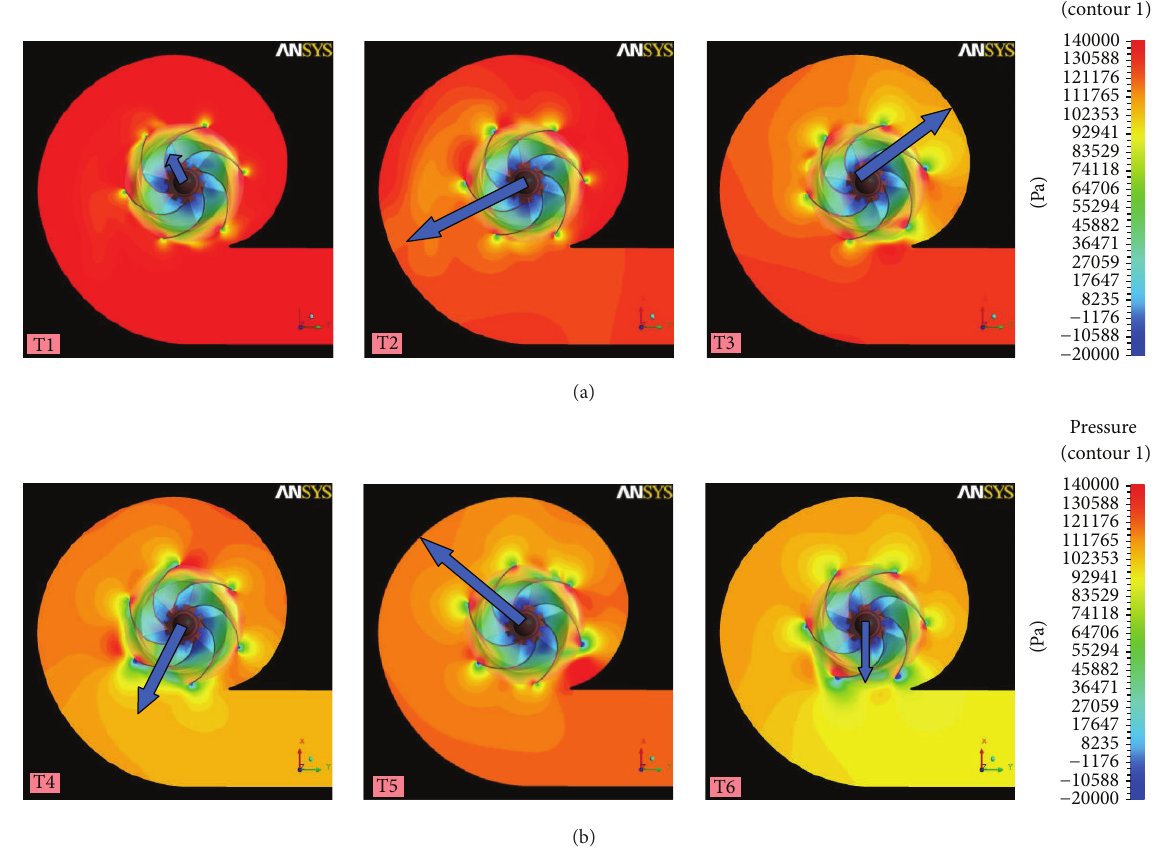
Figure 14: Instantaneous pressure field and radial trust evolution for the following operating point: − rpm /𝑄 = −0.6𝑄 𝑛 .